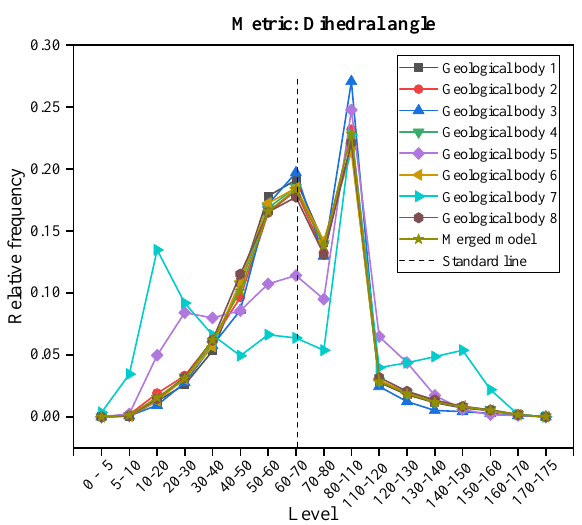
Figure 9. Statistics of the mesh quality of dihedral angle